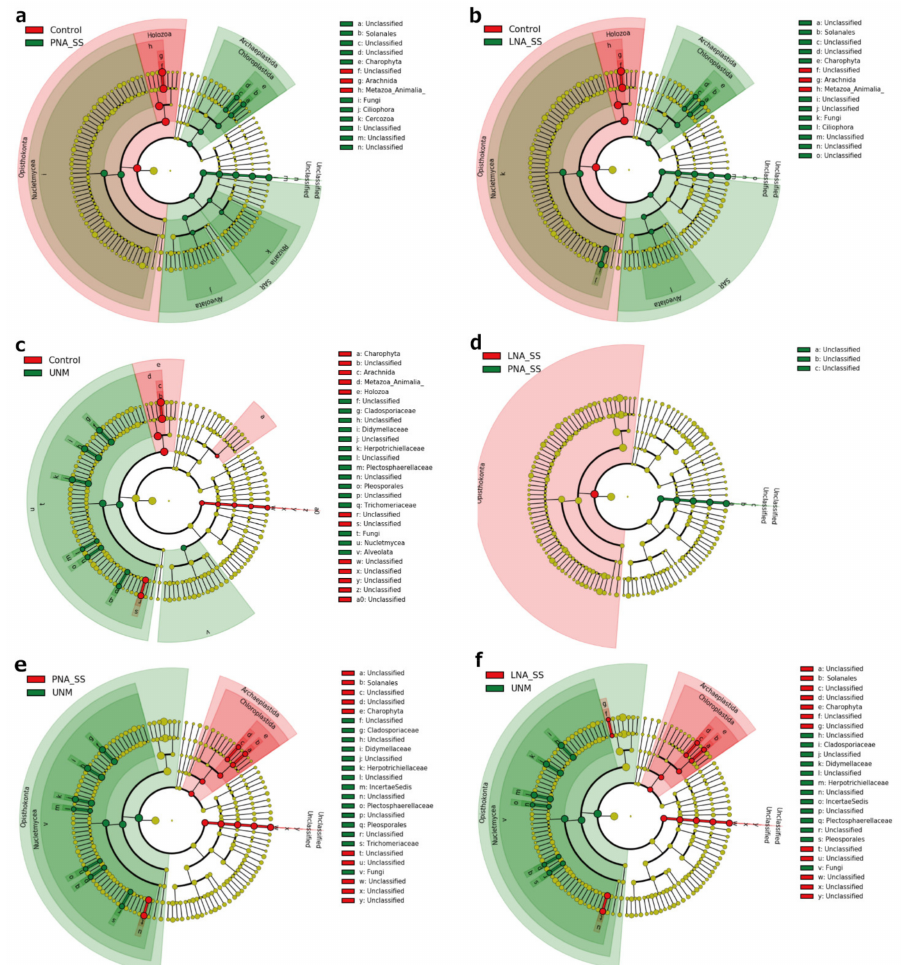
Figure 6. Cladogram showing abundant eukaryotic taxa detected upon using the control, TickB_PNA, TickB_LNA, and UNonMet-PCR methods. SizeSelect was used as a purification method for all blocker-based amplification products. The universal primer sets TAReuk454FWD1 and TAReukREV3 were used for control PCR, TickB_PNA, and TickB_LNA. The primer sets EUK581F and EUK1134R for the first PCR and E572F and E1009R for the second PCR were used for UNonMet- PCR (UNM). LEfSe was conducted for comparisons between ( a ) the control and TickB_PNA, ( b ) the control and TickB_LNA, ( c ) the control and UNM, ( d ) TickB_PNA and TickB_LNA, ( e ) TickB_PNA and UNM, and ( f ) TickB_LNA and UNM. LEfSe analysis was conducted, including tick